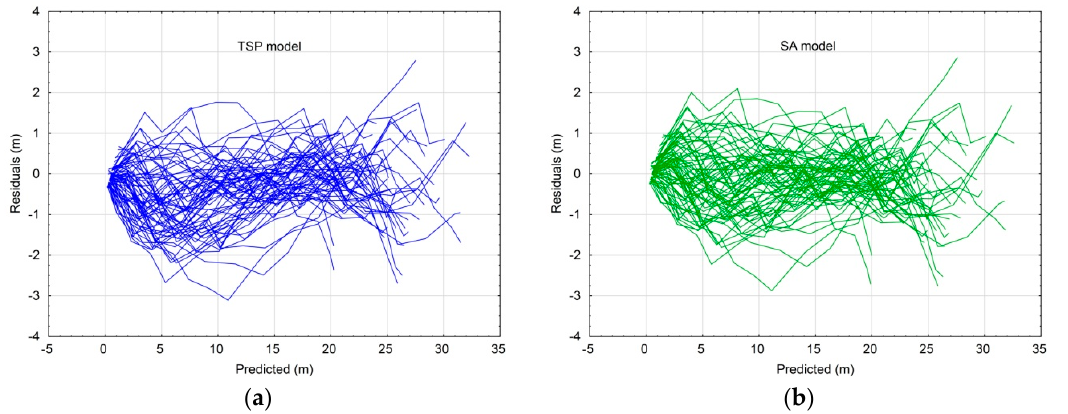
Figure 6. Di ff erences between observed growth trajectories obtained by stem analysis of 67 trees collected in the Second Natural Forest Region in Poland and height growth trajectories calculated using the model developed with TSP data ( a , blue lines) and the model fitted to stem analysis (SA) data ( b , green lines).